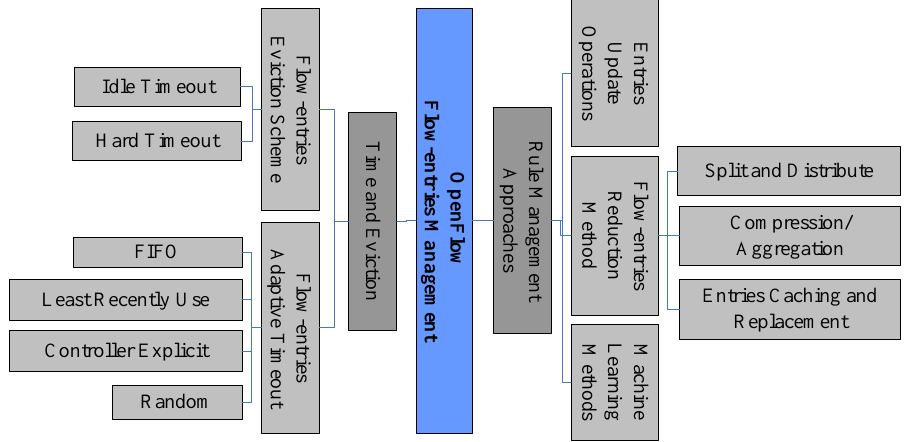
Figure 4. Taxonomy of SDN-switch flow-entry management. Table 1. Comparison of the improvement of TCAM, flow-table, and flow-entry